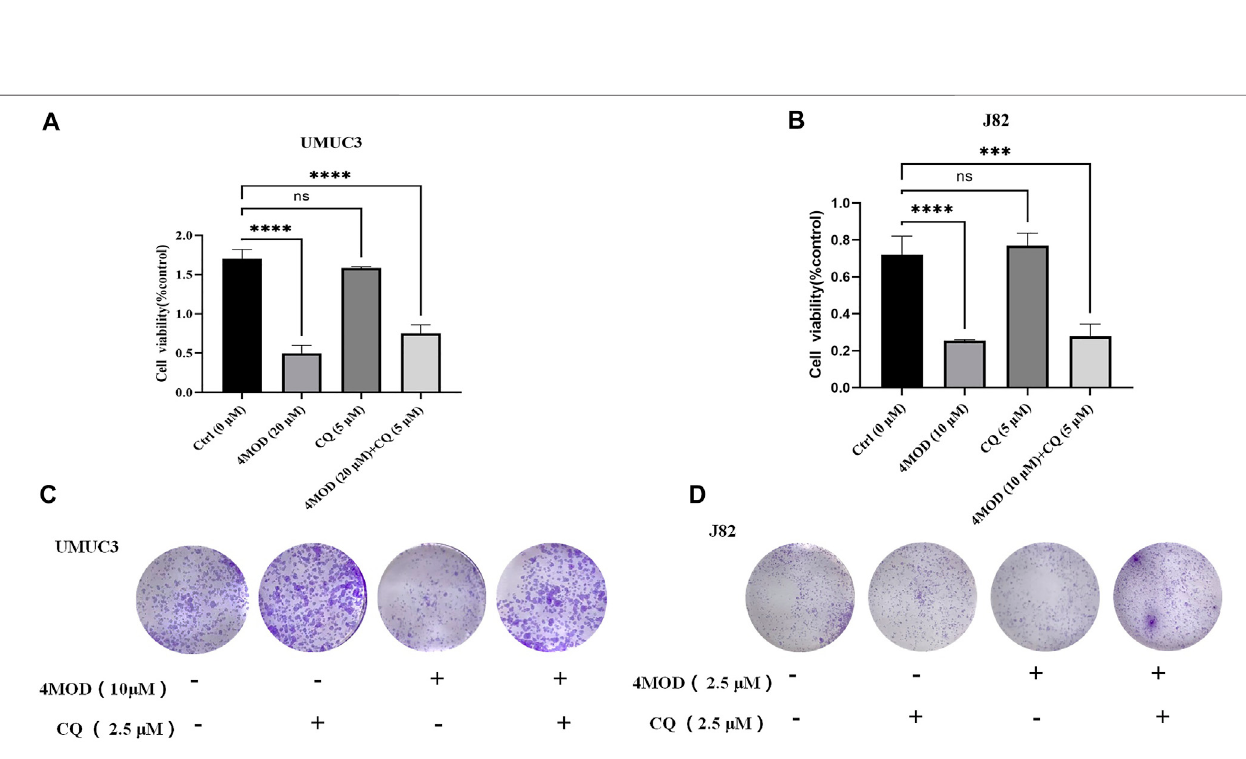
FIGURE5| Antagonismaction ofcombinationof4MODwithCQonproliferationandcolonyformationinBCCells (A – B) Cell viabilitywasassessed aftertreatment of 4MOD alone or 4MOD combined with CQ for 72 h (C – D) UMUC3 and J82 cells were treated for 7 days with 4MOD combined with CQ and then stained with crystal violet to allow colony